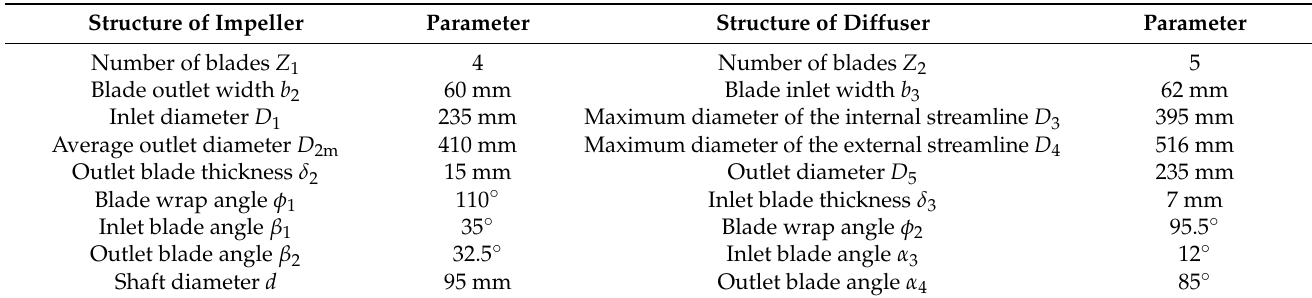
Figure 1. Structure of the deep-sea mining pump. Table 1. The main parameters of the impeller and diffuser.